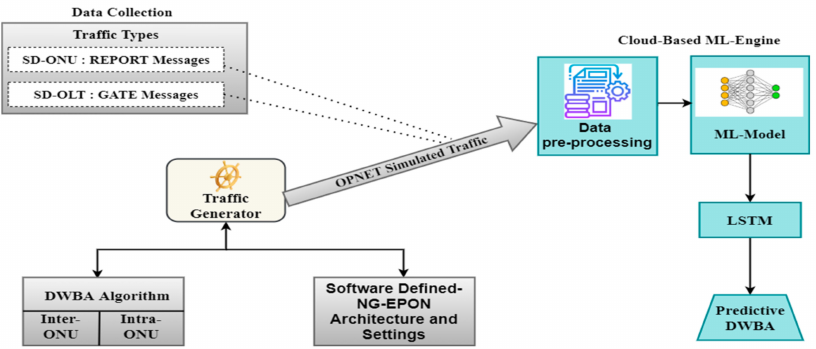
Figure 3. ML system